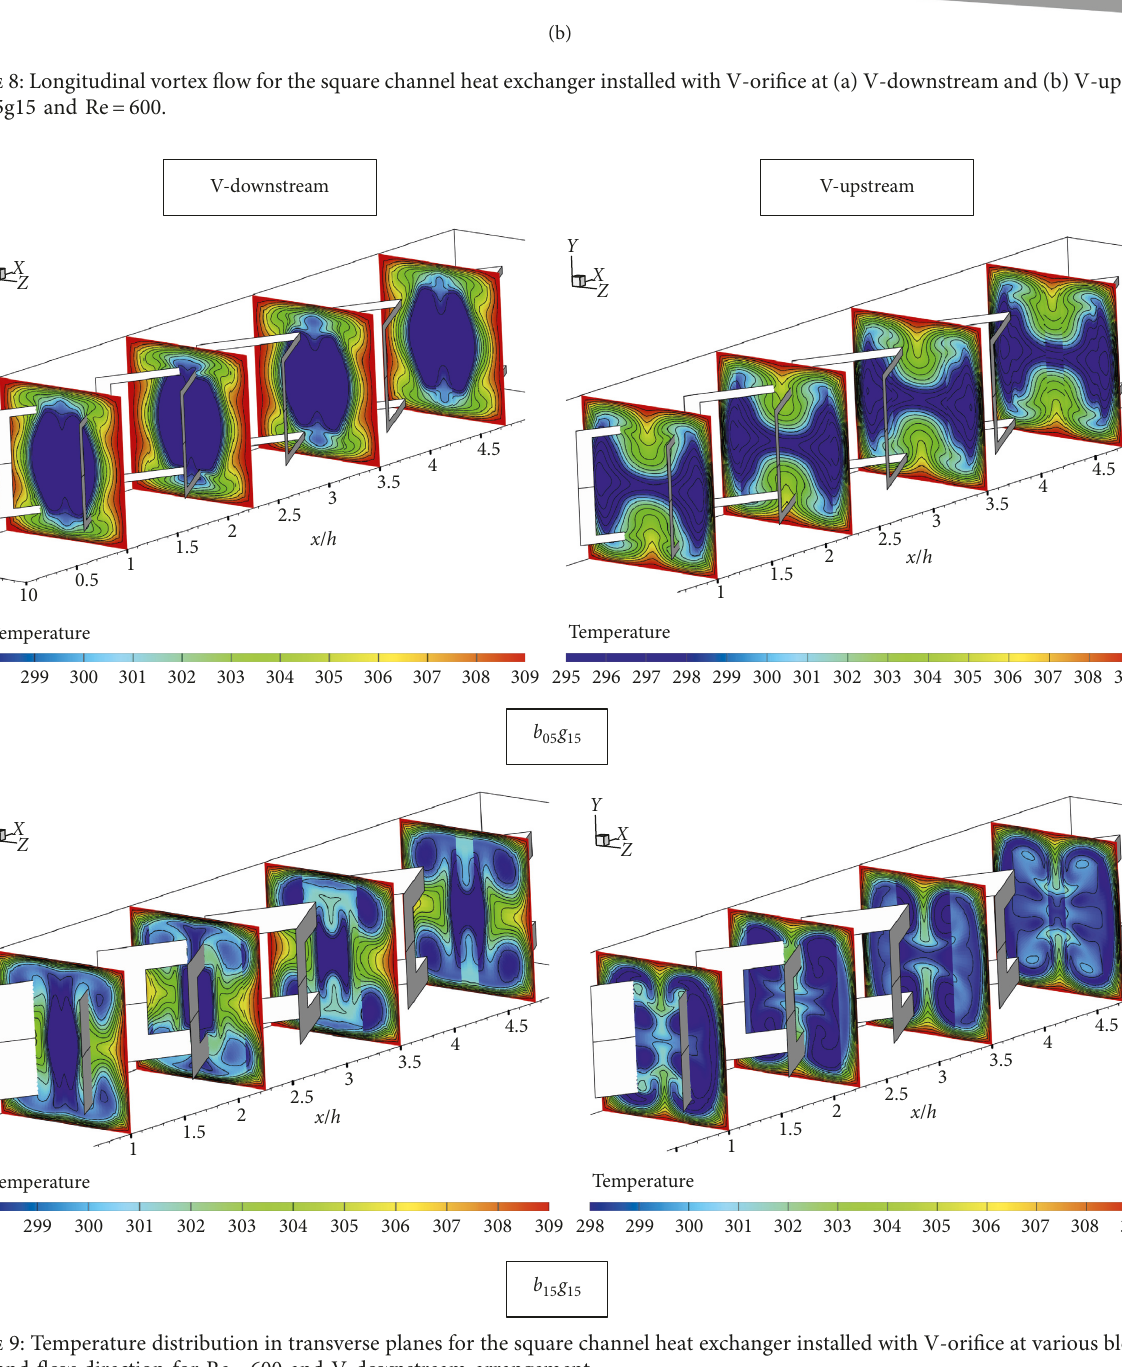
Figure 9: Temperature distribution in transverse planes for the square channel heat exchanger installed with V-orifice at various blockage ratios and flow direction for Re 600 and V-downstream (cid:31)